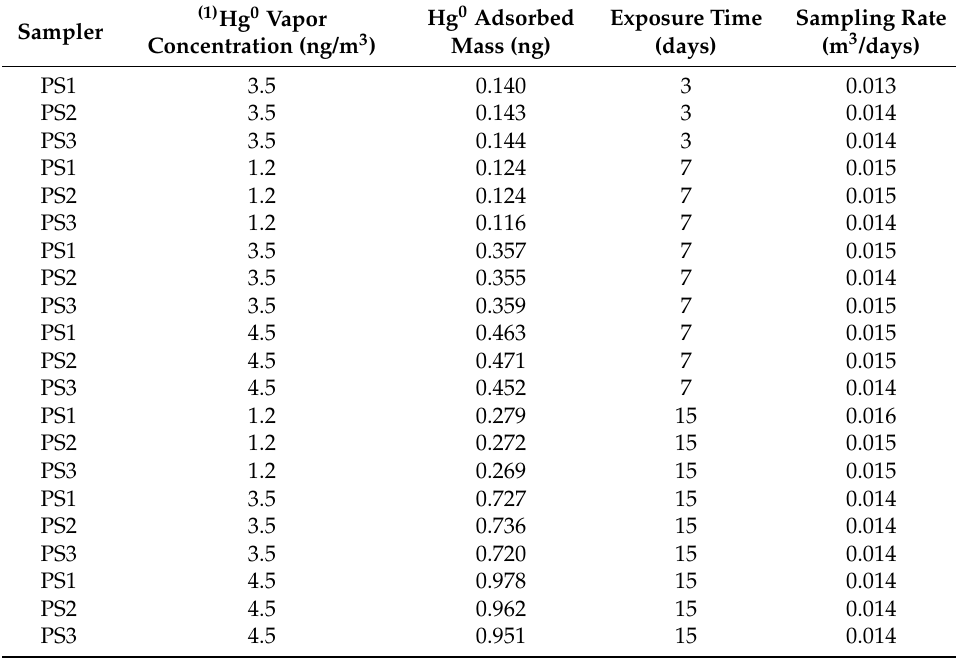
Table 1. Passive devices sampling rate